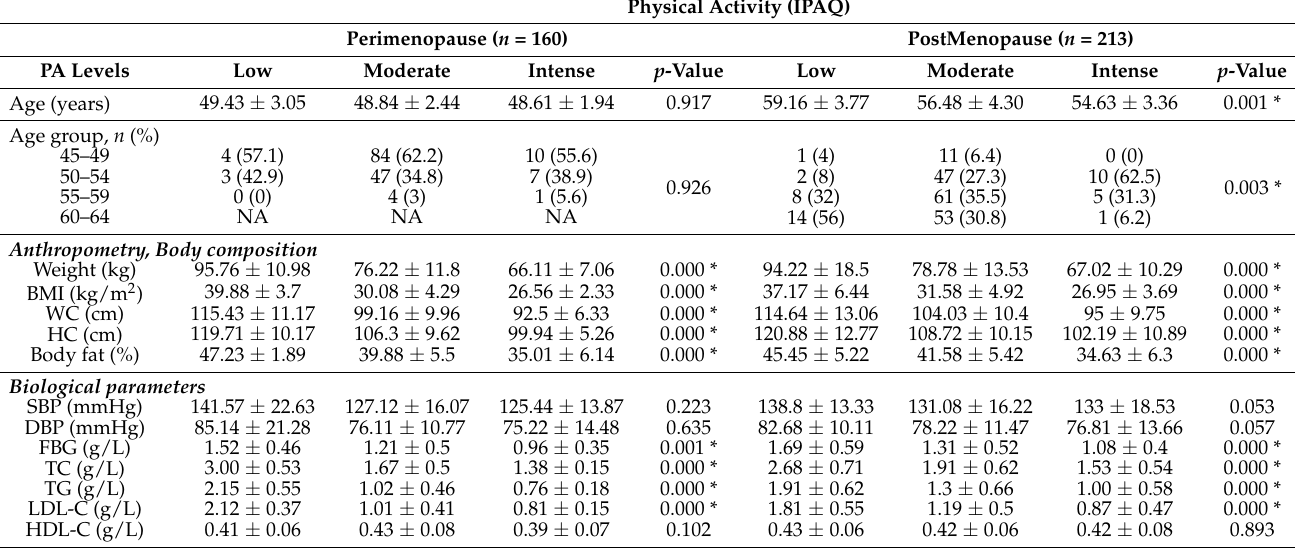
Table 2. Anthropometric and biological parameters of the study classified by physical activity